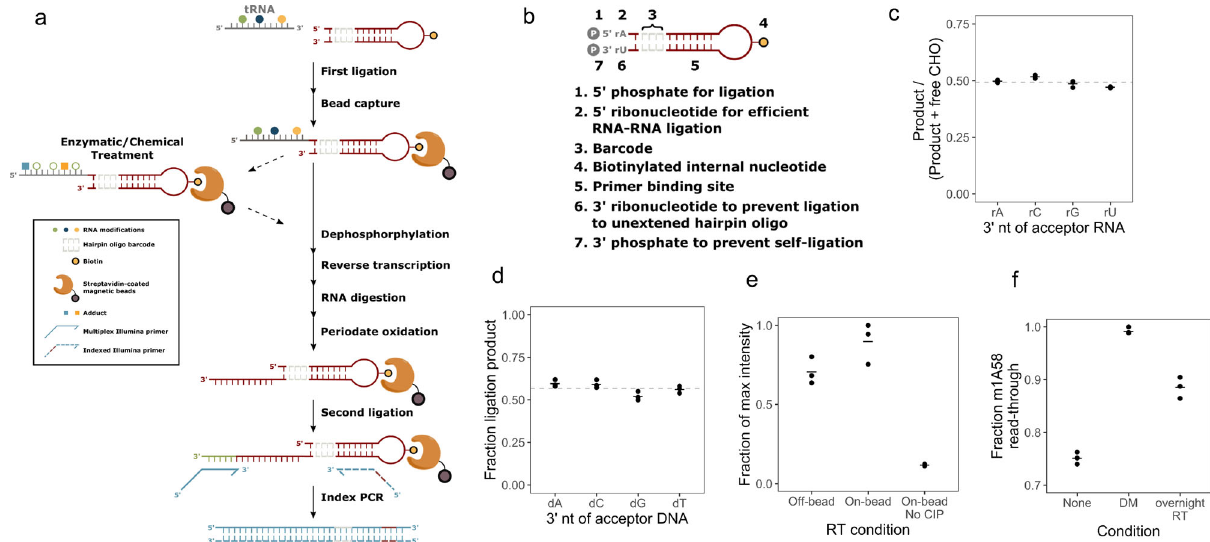
Fig. 1 Design and optimization of MSR-seq. a Schematic representation of multiplex small RNA-seq. The required steps are indicated in solid arrows and optional steps in dashed arrows. Symbols are explained in the box. b Features of the capture hairpin oligo (CHO) with detailed descriptions for each feature. c Fraction of ligation products for the test RNA oligonucleotides containing rA, rC, rG, and rU at the 3 ′ end. n = 3 independent experiments. Quantitative data were from denaturing gels stained with SYBR Gold shown in Supplementary Fig. 1a. The mean value is shown as a bar; the mean of all replicates is shown as a dashed line. The molar ratio as measured by UV absorbance of input RNA and the CHO in the ligation reaction was ~1:2. Fraction product is calculated as (Product)/(Product + Free CHO). The expected stoichiometric amount of ligation product corresponds to ~0.5. d Fraction of ligation products for the test 5 ′ biotinylated deoxyoligonucleotides containing dA, dC, dG, and T at the 3 ′ end. n = 3 independent experiments. Quantitative data were from denaturing gels stained with SYBR Gold shown in Supplementary Fig. 1b. The mean value is shown as a bar; the mean of all replicates is shown as a dashed line. Fraction product is calculated as (Product)/(Product + Free 5 ′ biotin-oligo). e Relative reverse transcription products with RT performed free in solution (off-bead), on streptavidin bead (on-bead), and on-bead without calf-intestine alkaline phosphatase treatment (No-CIP). Input samples were total RNA from HEK293T cells. n = 3 independent experiments. Quantitative data were from native gels stained with SYBR Gold shown in Supplementary Fig. 1c. The mean value of replicates is shown as a bar. Product is de fi ned as all bands above the terminal transferase product of the RT (TdT) band in Supplementary Fig. 1c. Fraction product is calculated as (Product in each sample)/(sample with the maximum amount of product). The non- zero value from No-CIP samples was from spurious oligos associated with the beads, see Supplementary Fig. 1c. f Fraction of reverse transcriptase m 1 A58 read-through product with no demethylase treatment/short RT reaction (none), demethylase treatment/short RT reaction (DM), and no demethylase treatment/long RT reaction (overnight RT). Input samples were total RNA from HEK293T cells. n = 3 – 4 independent experiments. Quantitative data were from native gels stained with SYBR Gold shown in Supplementary Fig. 1e, h. The mean value of replicates is shown as a bar. Product is de fi ned as all bands above the m 1 A58 band in Supplementary Fig. 1e, h. Product is de fi ned as all bands above the TdT band in Supplementary Fig. 1c. Fraction product is calculated as (Product)/(Product + m 1 A58